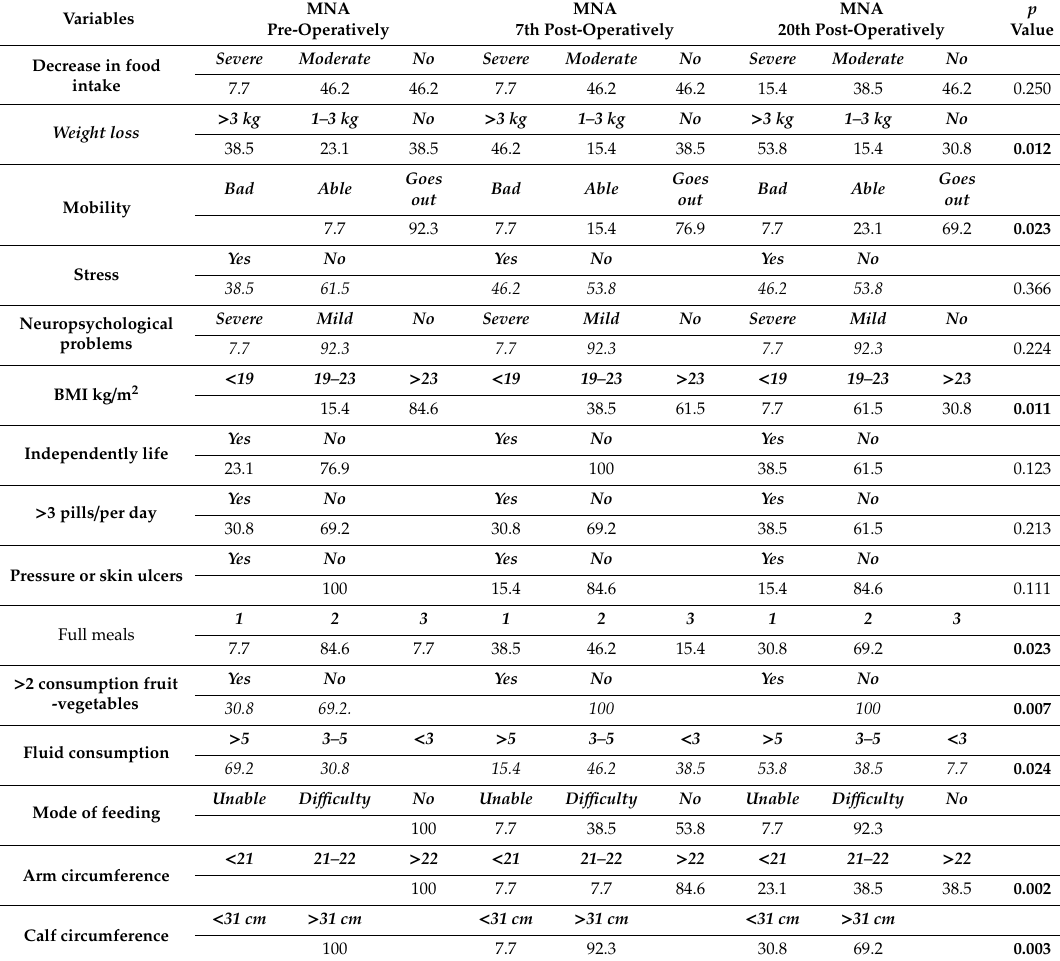
Table 3. Factors associated with MNA ( n =